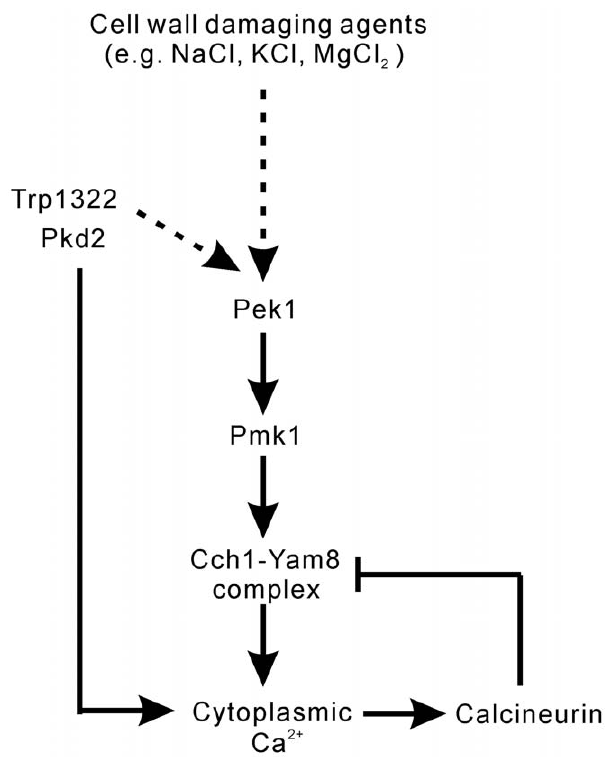
Figure 8. A cartoon figure illustrating a molecular mechanism of Ca 2 + signaling. The cell wall damaging agents (e.g. NaCl, KCl, MgCl 2 ) activate the cell wall integrity MAPK Pmk1, then the activated Pmk1 phosphorylates Cch1, resulting in the opening of the Cch1-Yam8 channel and in Ca 2 + influx. In the absence of FK506, the increase in the cytoplasmic Ca 2 + level activates calcineurin, which in turn dephosphor- ylates Cch1, resulting in the closing of the channel. In the presence of FK506, calcineurin is inhibited, thus resulting in the persistent opening of the Cch1-Yam8 channels. Trp1322 and Pkd2 directly regulates calcium influx, and also may crosstalk with other components of the Pmk1 MAPK pathway upstream of Pek1, thus indirectly affecting the Cch1-Yam8 complex upon NaCl plus FK506